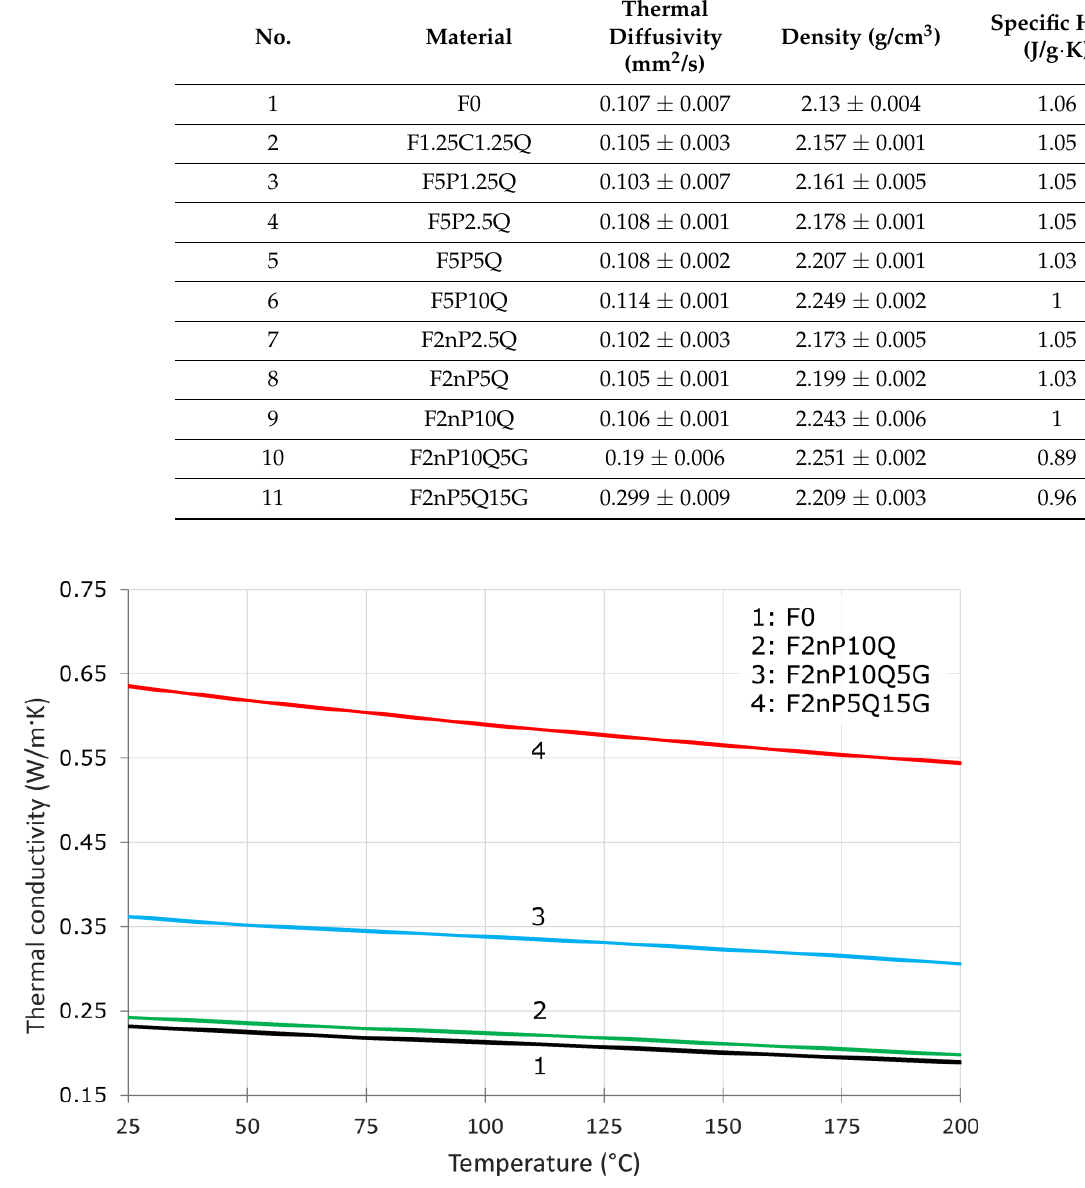
Table 3. The results of mechanical and thermo-mechanical properties of the unfilled FEP and FEP-based composites. No.